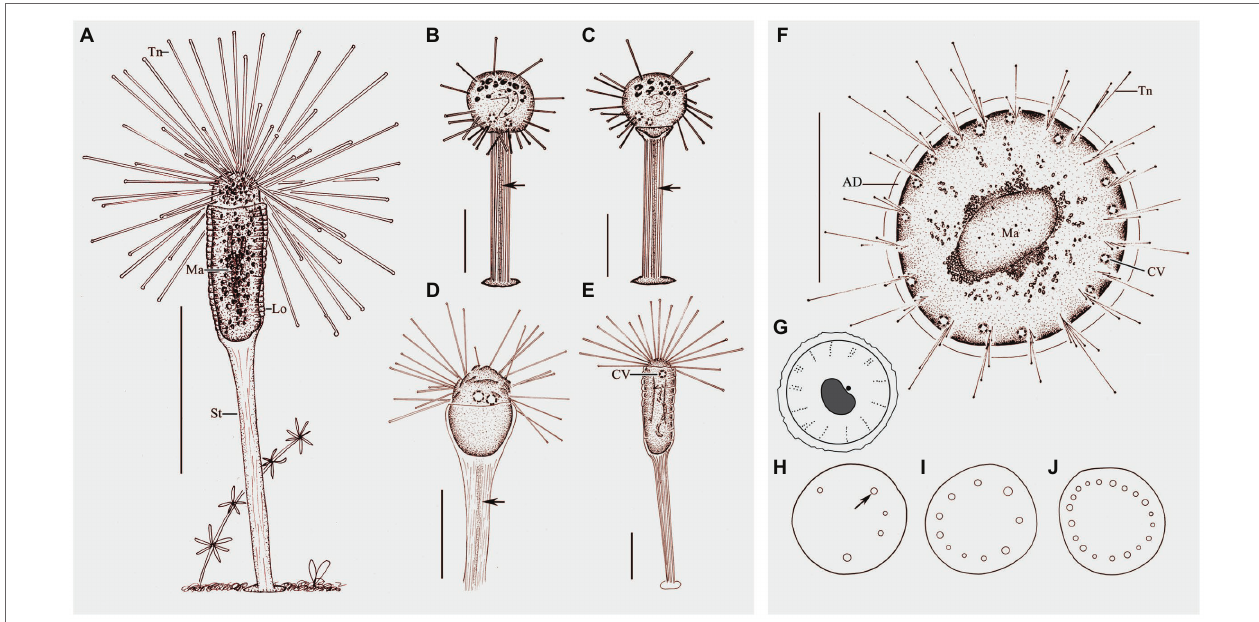
FIGURE 4 | Morphology of Peridiscophrya florea (Kormos & Kormos, 1958) Dovgal, 2002 (A–E) and Heliophrya rotunda (Hentschel, 1916) Matthes, 1954 (F–J) . (A) View of Peridiscophrya florea from life. (B–E) The growth process of P. florea . Arrow marks some particles in stylotheca. (F) Heliophrya rotunda in vivo . (G) Arrangement of tentacles. (H–J) Different individuals with different number of contractile vacuoles. Arrow marks the contractile vacuole. AD, adhesive disc; CV, contractile vacuoles; Lo, lorica; Ma, macronucleus; St, stalk; Tn, tentacle. Scale bars = 100 μ m (A), = 50 μ m (B–F) .